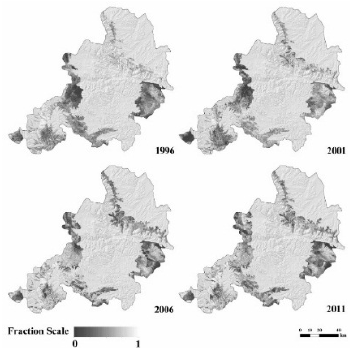
Figure 2. Vegetation fractional results for 1996, 2001, 2006 and 2011, with light areas on the maps indicating highly vegetated regions.